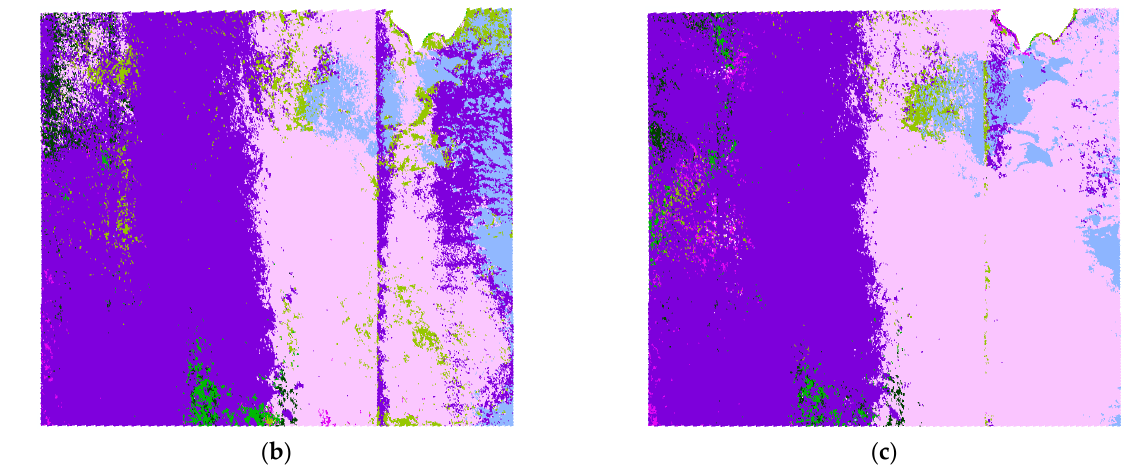
Figure 12. Sea ice distribution map of SAR scene on 24 November 2020. ( a ) The weekly regional ice chart on 23 November 2021 provided by CIS. The red rectangle represents the position of the tested SAR scene in ice chart; ( b ) sea ice distribution map obtained with model 3; ( c ) sea ice distribution map obtained with model